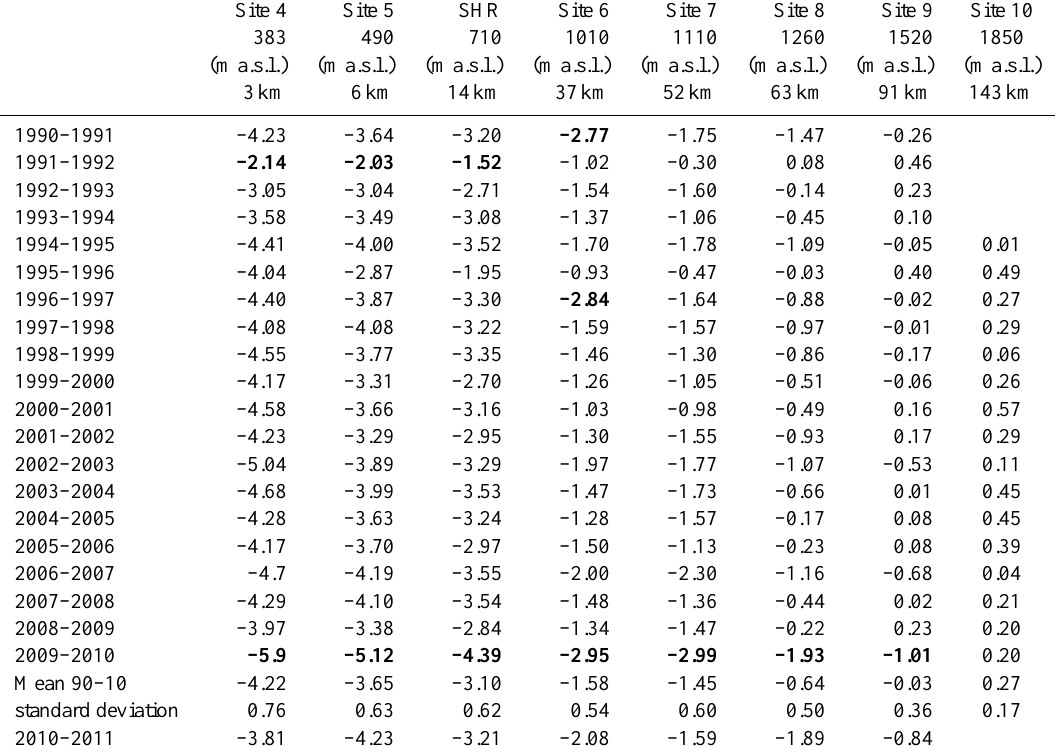
Table 1. Surface mass balance measurements (in mw.e.) along the K-transect at 67 ◦ N. Distances are presented in kilometres from the western ice margin. Values at S4 are recalculated to a height of 383ma.s.l. Bold values are outside the 2 σ interval with respect to the 20yr mean (1990–2010) and standard